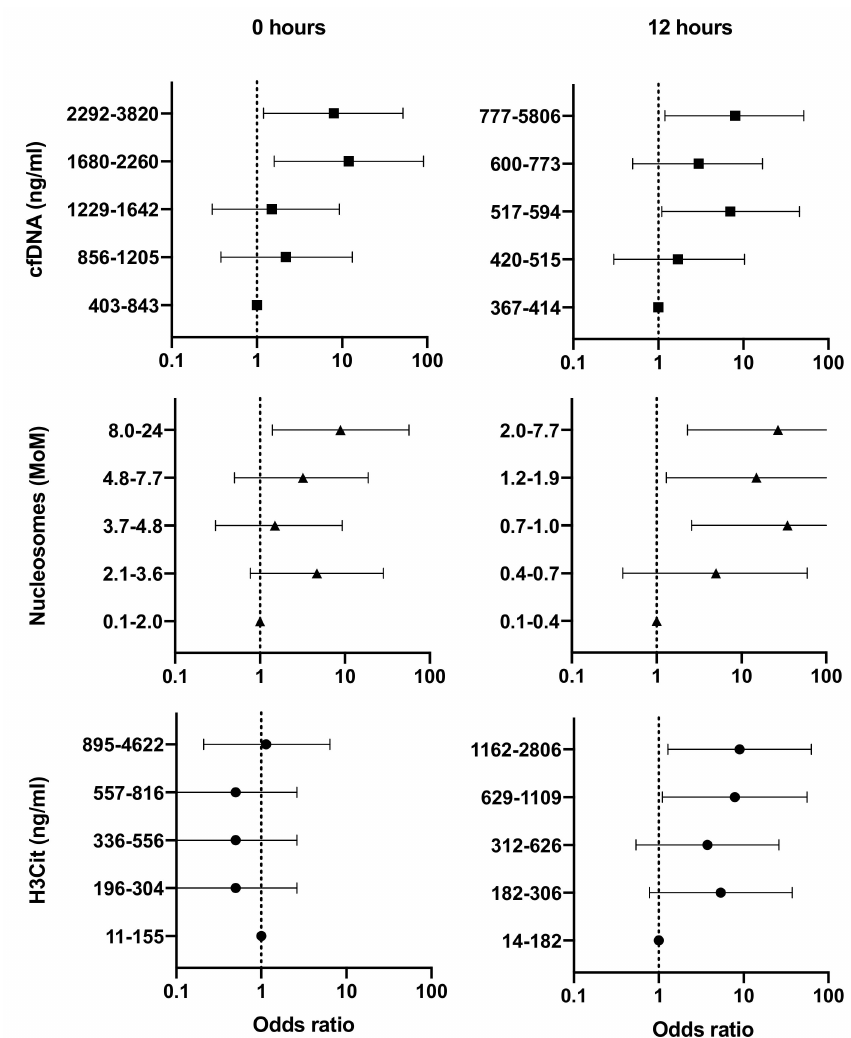
Figure 2. The crude odds of poor 30 day neurologic function ( x -axis; crude odds ratio, log scale) according to plasma level quintiles of NET components ( y -axis) on admission (left) and at 12 h (right). Confidence bands represent 95% confidence intervals. MoM,